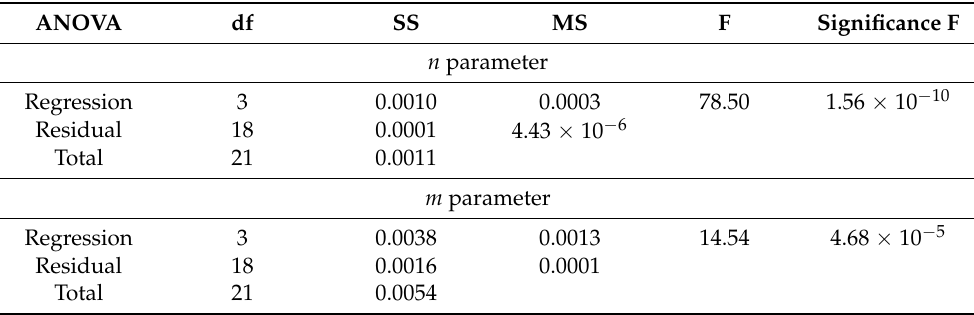
Table 3. For n and m parameters, ANOVA of the linear multiple